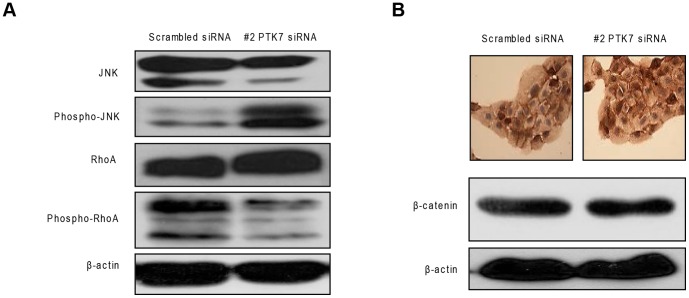
Effect of PTK7-specific siRNA on Wnt pathway in HuCCT1 cells.(A) Results of the PTK7 silencing on the non-canonical Wnt pathway (PCP)-related proteins. (B) Western blotting (lower panel) and immunohistochemistry staining (upper panel) of β-catenin on HuCCT1 cells with siRNA treatment (original magnification, 400×).